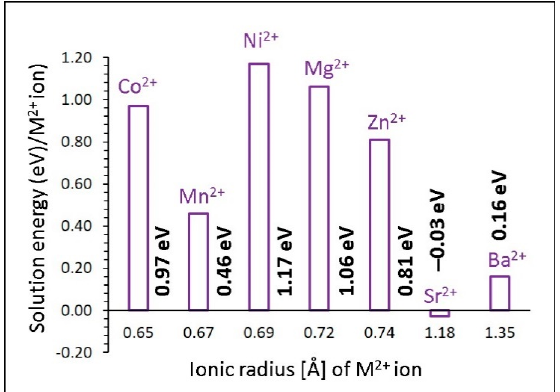
Figure 5. Solution energy of MO (R = Co, Mn, Ni, Mg, Zn, Sr and Ba) with respect to the M 2+ ionic radius.